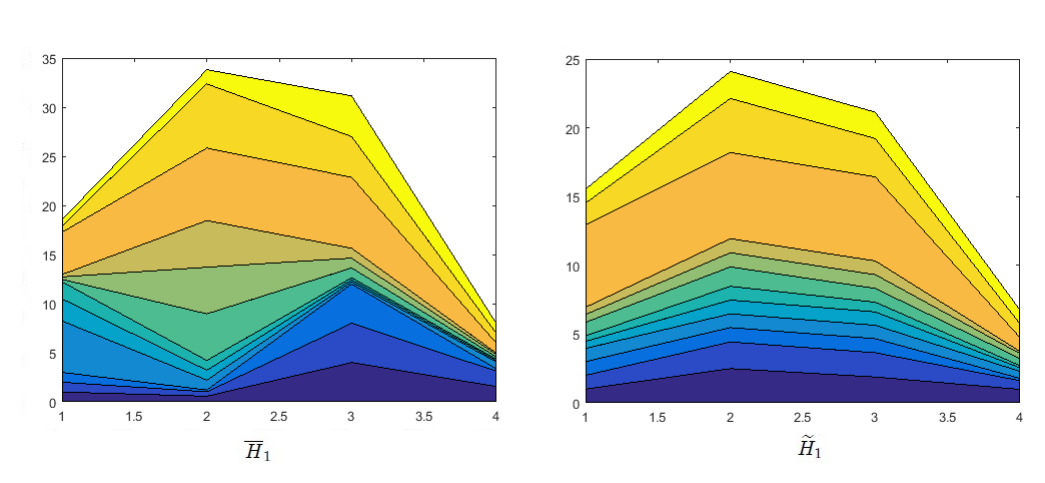
Figure 1. Area graphs of multiplicative preference degrees for H 1 .